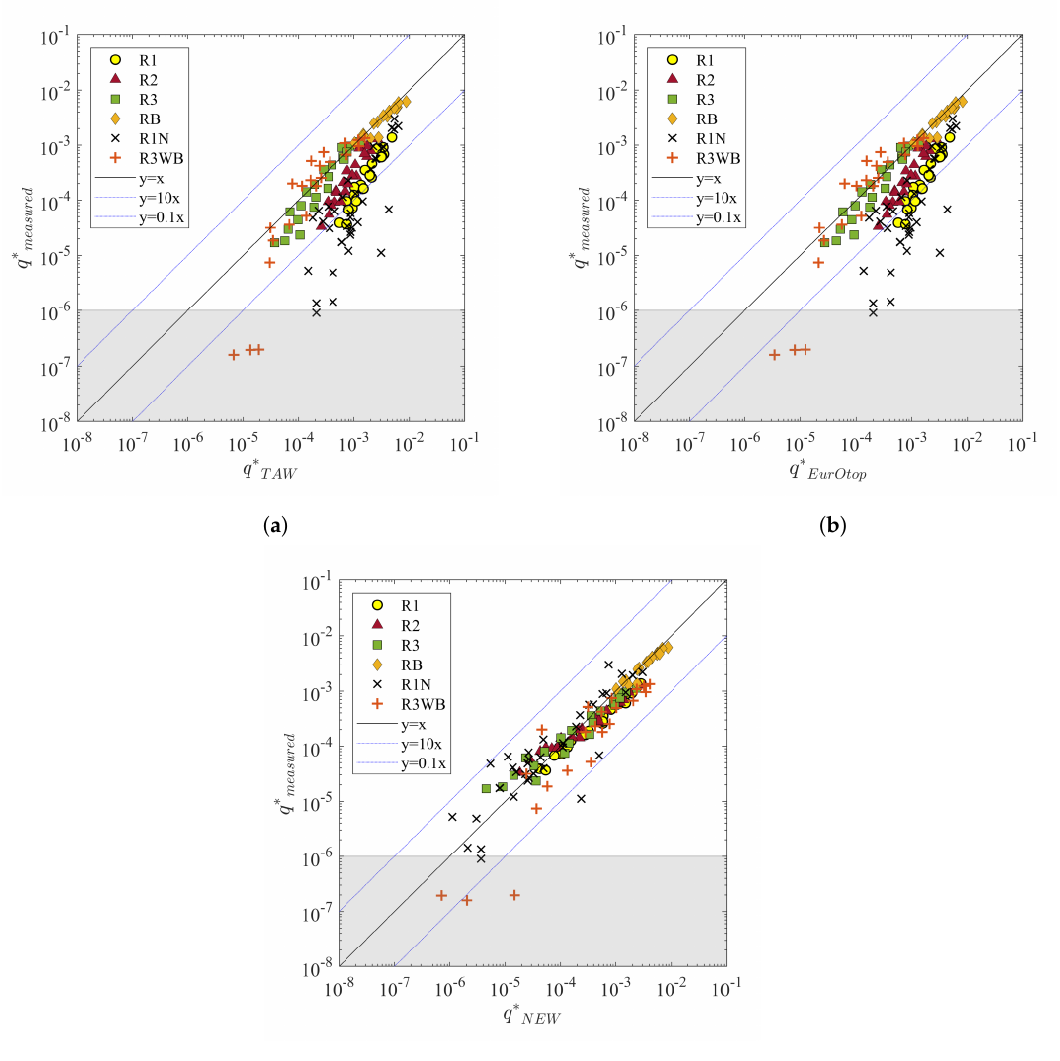
Figure 18. Comparisons of measured and predicted dimensionless average overtopping discharges calculating using ( a ) TAW equations given by [6], ( b ) EurOtop equations given by [10] and ( c ) New equations for all data